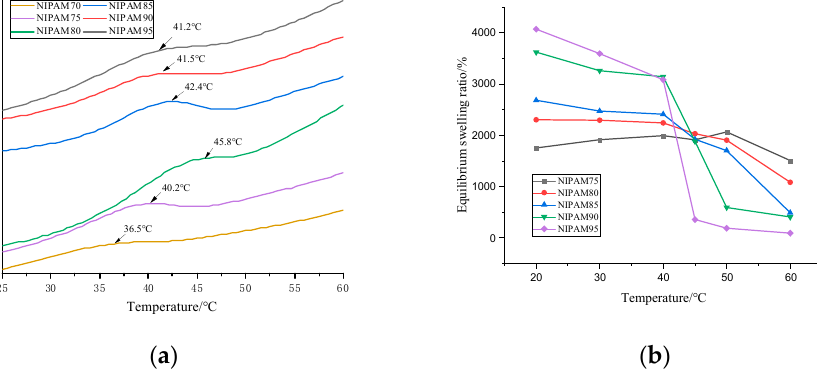
Figure 4. ( a ). Differential scanning calorimetry (DSC) curves of the GA–P(NIPAM ‐ co ‐ DMAPMA) hydrogels with different NIPAM contents. ( b ) Relationships of the equilibrium swelling ratio and the temperature for the GA–P(NIPAM ‐ co ‐ DMAPMA) hydrogels with different NIPAM contents. The glass transition temperature of the hydrogels increased from 118 to 142.4 °C